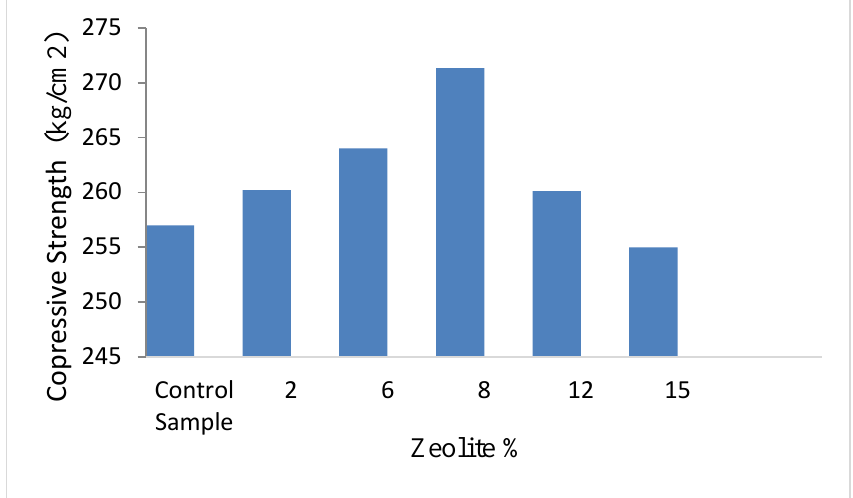
Fig. 8: Concrete strength with different percentages of Zeolite with 360 grade cement at 28 days of